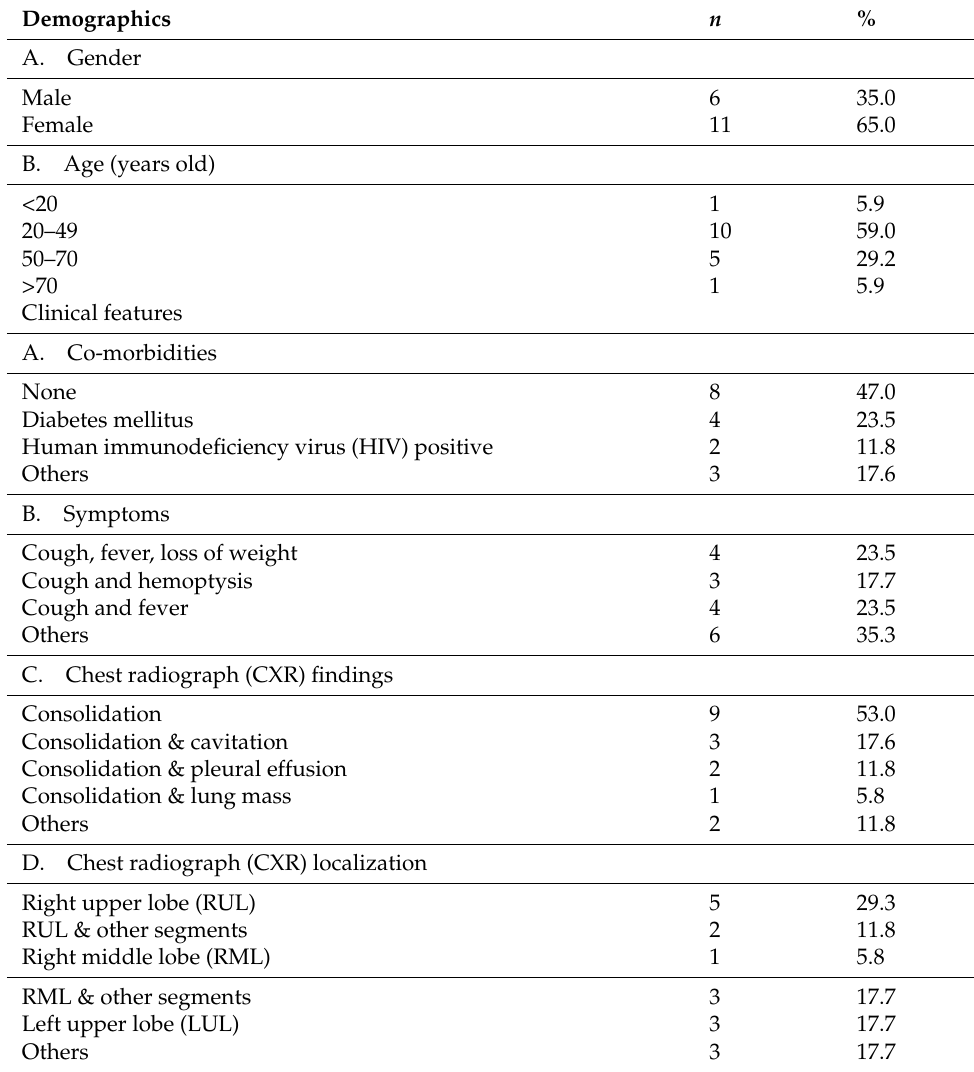
Table 1. Demographics and clinical data of EBTB